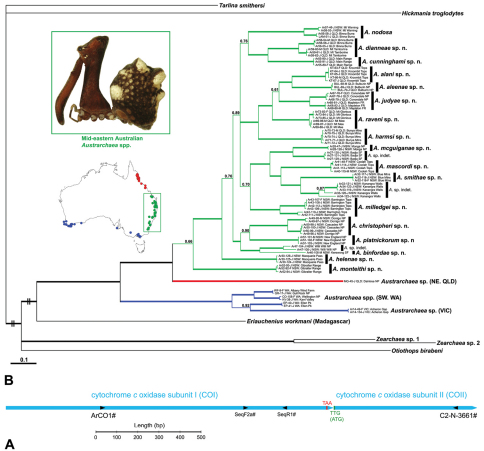
Molecular phylogenetic data analysed as part of this study. A, Schematic map of the mitochondrial cytochrome c oxidase subunit I–II (COI–COII) gene complex in Archaeidae and other basal Araneomorphae, showing (i) the position of primers used to amplify and sequence 1.6 kilobases of mtDNA, and (ii) the inferred stop and initiation codons for COI and COII, respectively. Note the centralised, overlapping position of the two internal sequencing primer sites (SeqF2a/SeqR1), and the TTG initiation codon for COII, present in all but one of the spider species sequenced for this study. B, Majority-rule consensus tree with re-estimated branch lengths, resulting from a combined, gene-partitioned Bayesian analysis of the COI–COII mtDNA data. Thickened branches represent clades with >95% posterior probability support, and individual support values are shown above other nodes.